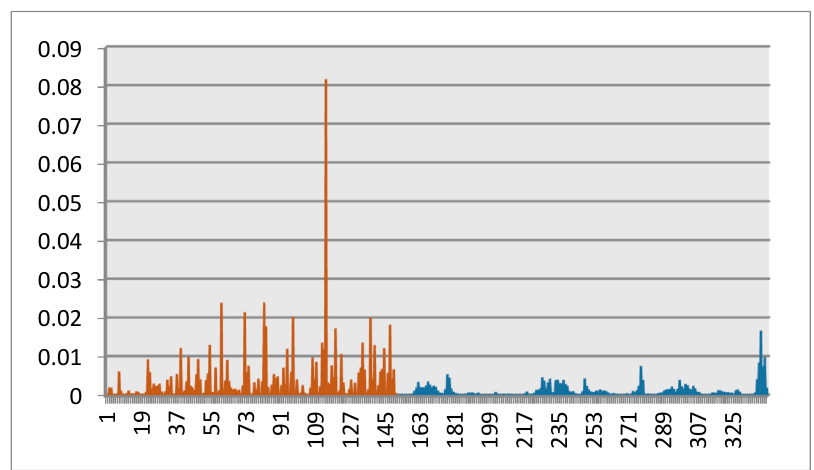
Figure 4. Learned weights using the new proposed approach on Sample query 2. Entries between 1 and 150 correspond to the edge histogram, and entries between 151 and 341 correspond to the color histogram.